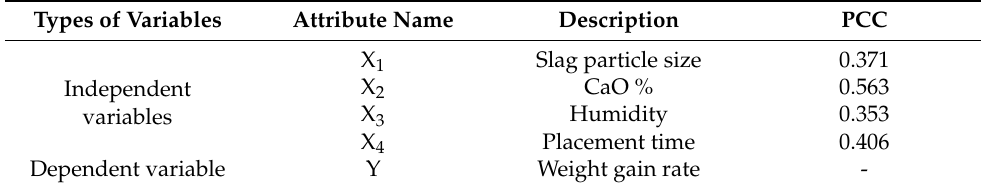
Table 2. Description of variables and the PCC.